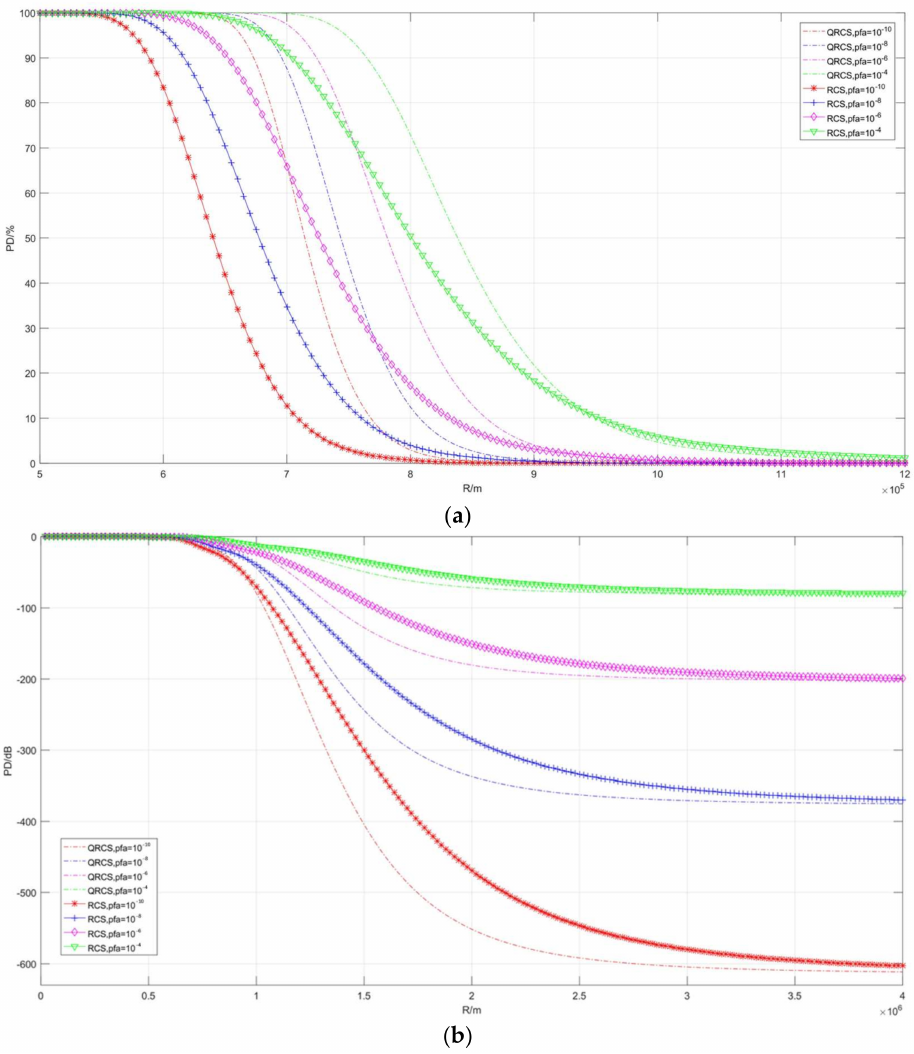
Figure 10. Correlation diagram of detection probability changing with distance (taking different P fa